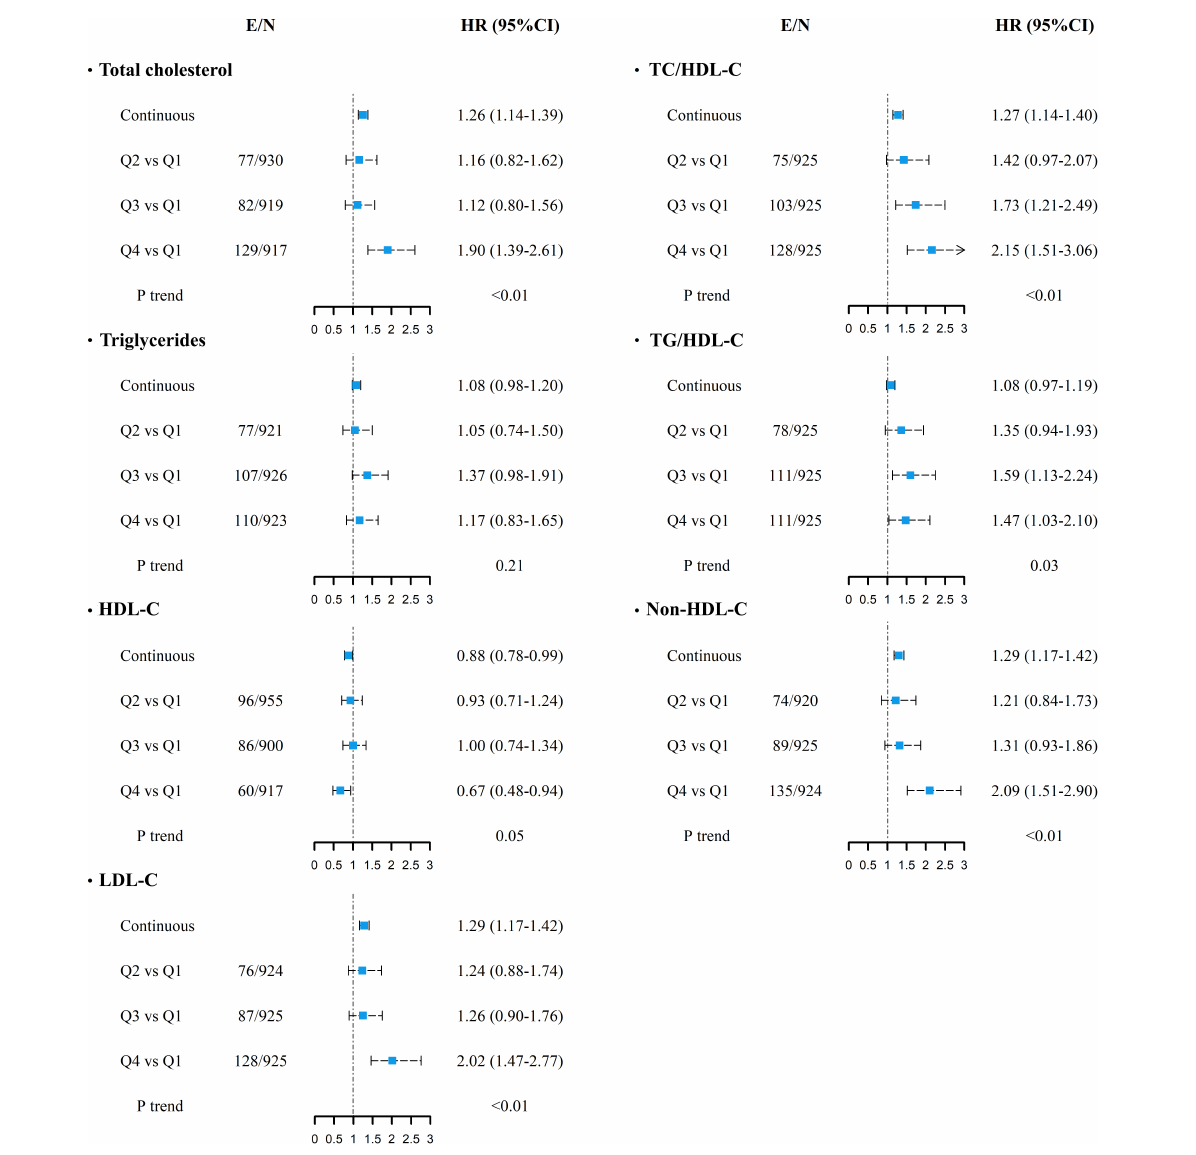
except for LDL-C, on the risk of CVD were observed (all p for interactions <